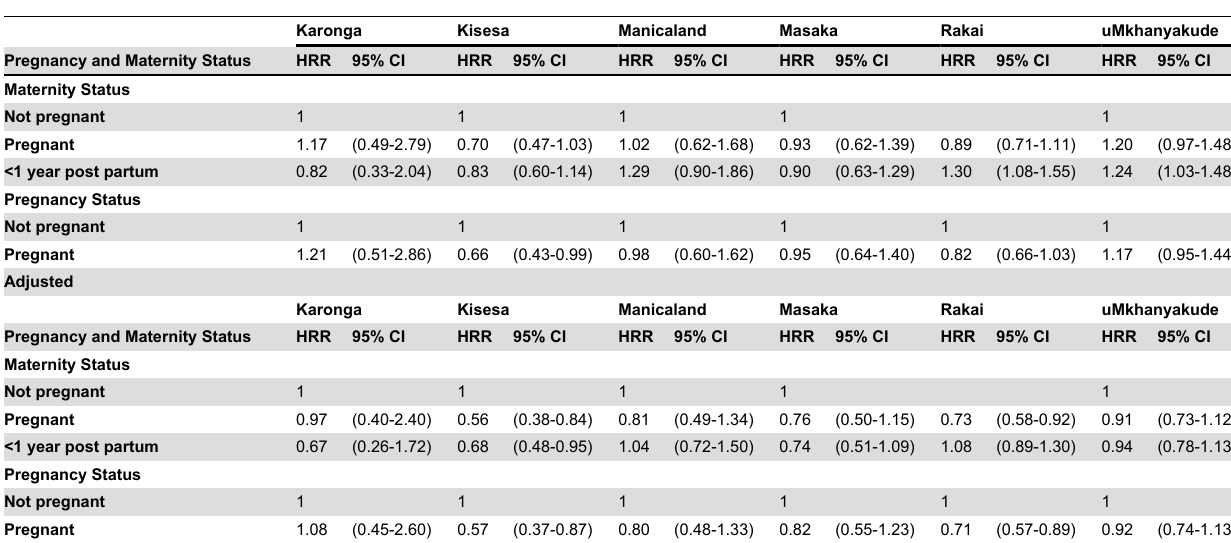
Table 7. Incident rate ratio adjusted for age comparing pregnancy status for all periods by study